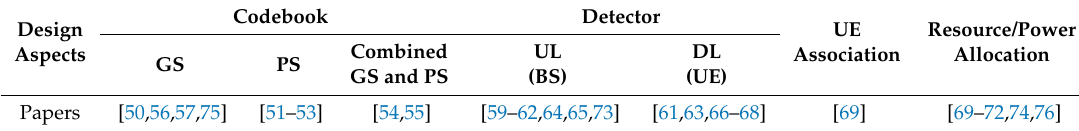
Table 3. Categories of advancements in